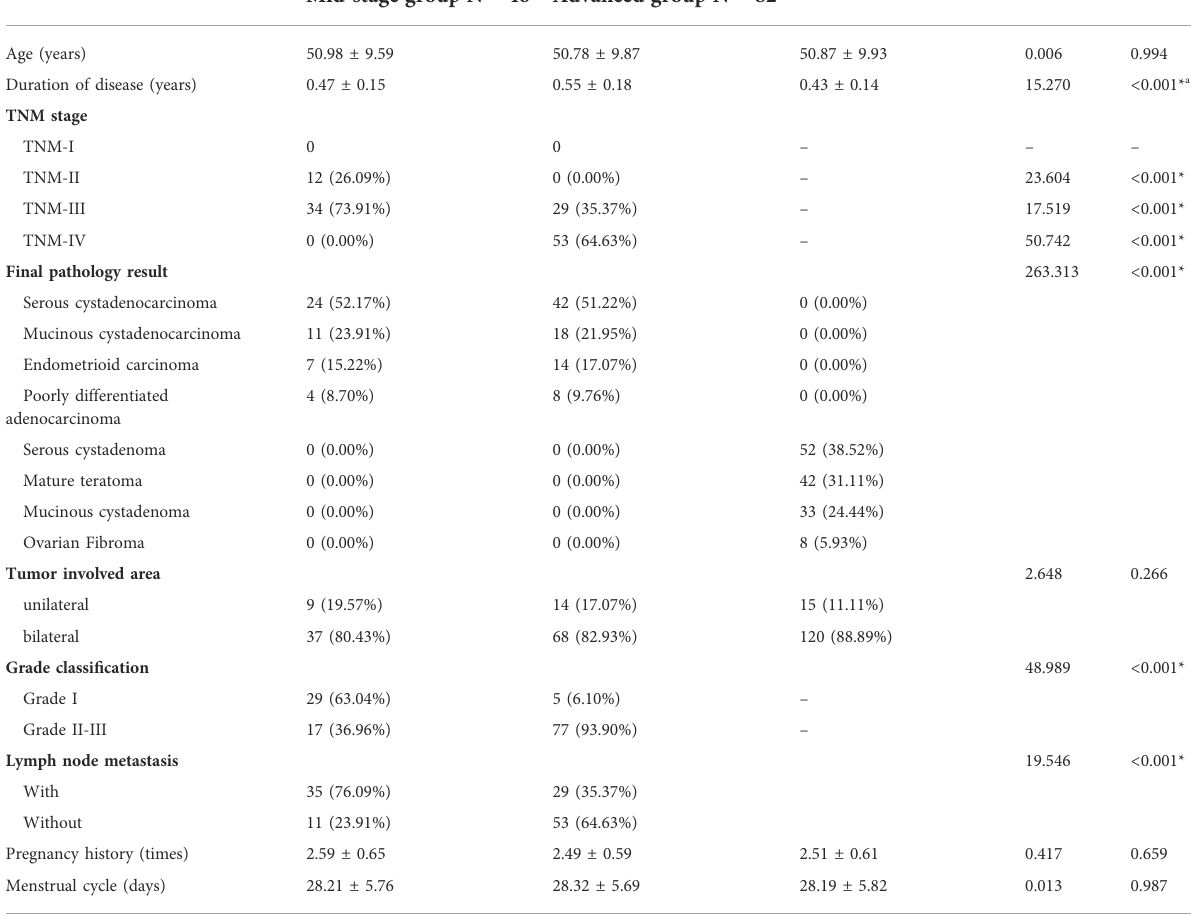
TABLE 1 | General information comparison.